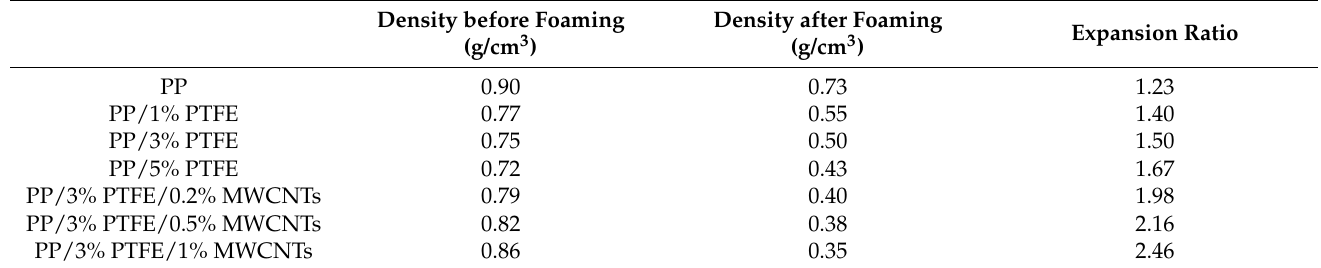
Table 5. Density of Composite before and after foaming.